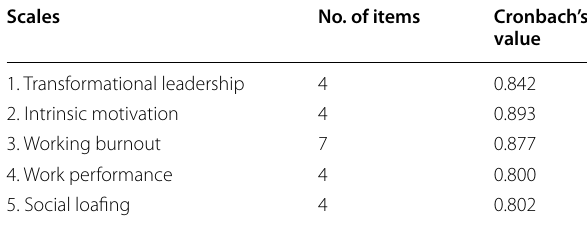
Table 3 Reliability statistics